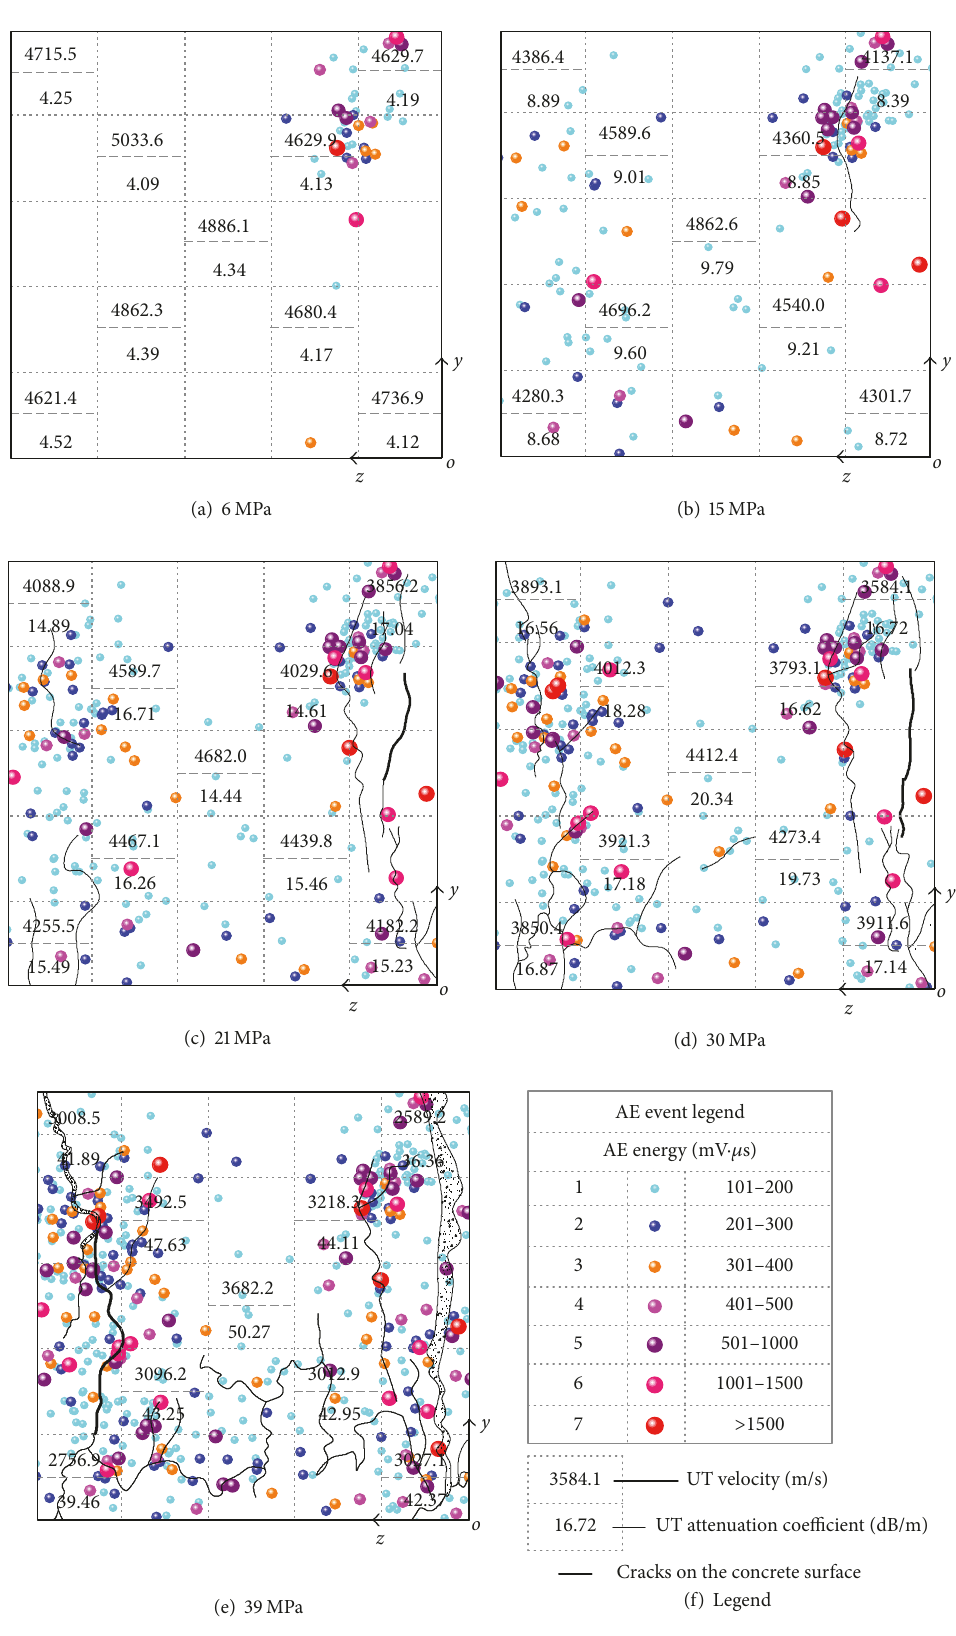
Figure 7: The spatial joint response characteristics of